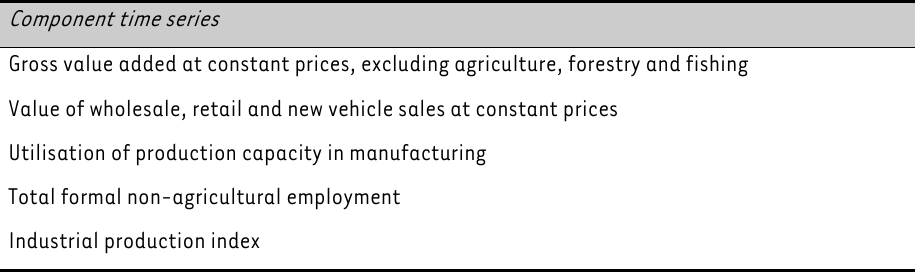
TABLE 1: Component time series of the composite coincident business cycle indicator in SA Component time